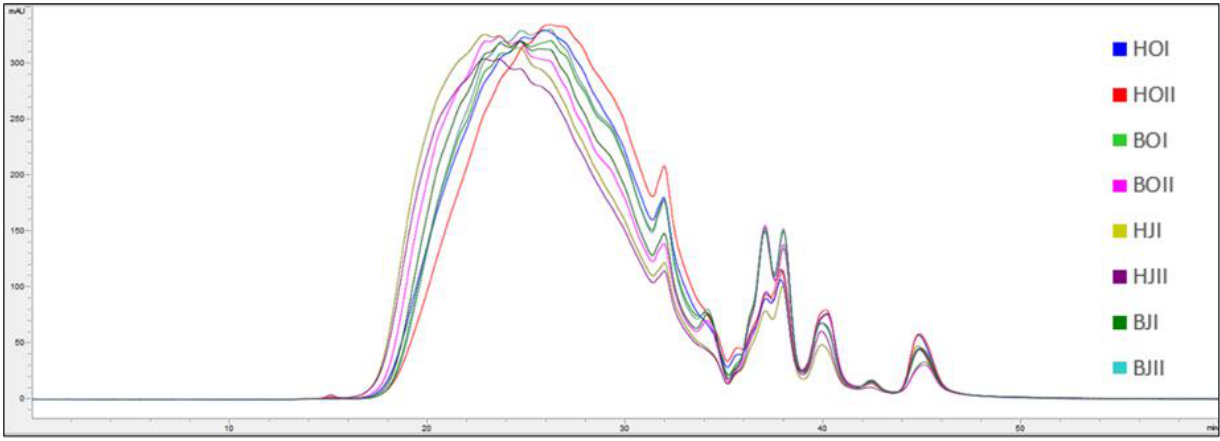
Figure 3. Chromatograms (mAU/min) from analysis of molecular weight distribution ( x ̅ ± SEM, n = 2) of saithe protein hydrolysates obtained from enzymatic hydrolysis of heads (H) and backbones (B), in two bioreactors (I, II), from saithe caught in October 2019 (HOI (blue), HOII (red), BOI (green), BOII (pink)) and January 2020 (HJI (beige), HJII (purple), BJI (dark green), BJII (turquoise)).